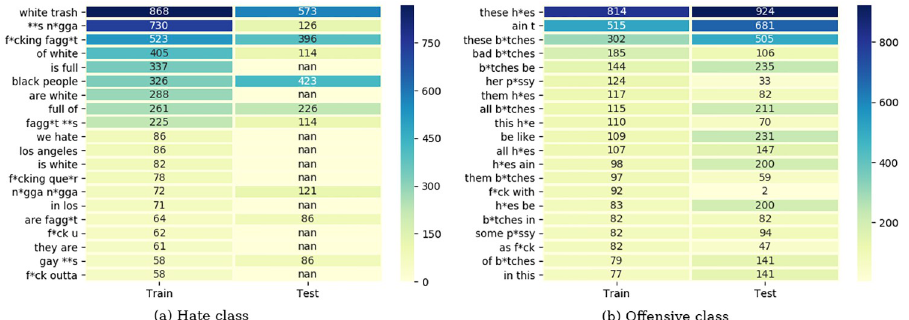
Fig 5. The top 20 LMI-ranked n -grams ( n = 2) that are highly correlated with the negative classes of Davidson dataset (Hate and Offensive) in the training and test sets. nan value denotes computationally infeasible, as the occurrence is zero in the test